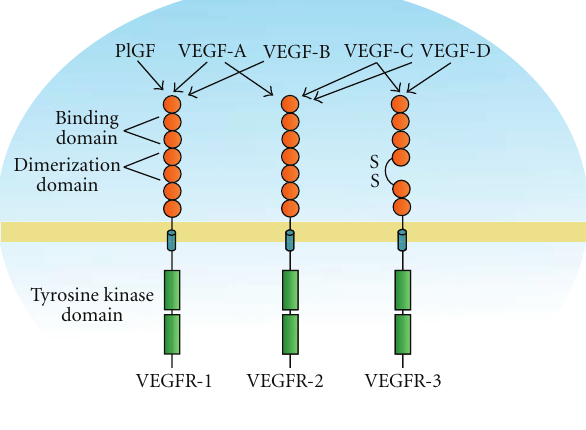
Figure 5: hERG1 potassium channel structure; PAS: Per Arnt Sim domain, cNBD: cyclic nucleotide-binding